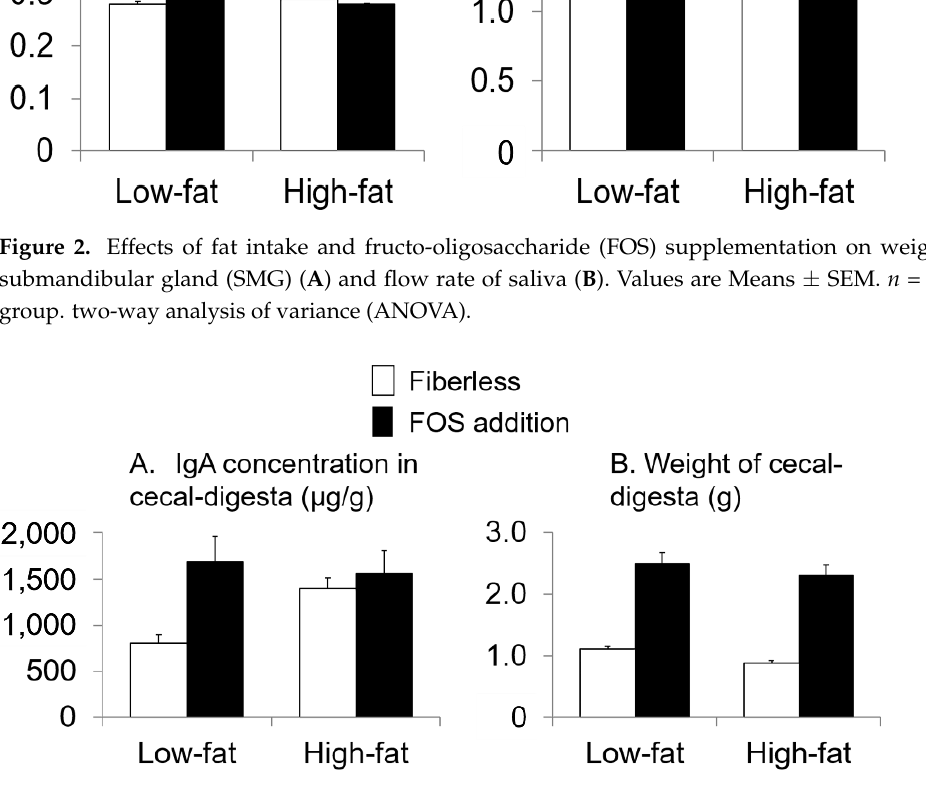
Figure 2. Effects of fat intake and fructo-oligosaccharide (FOS) supplementation on weight of sub- mandibular gland (SMG) ( A ) and flow rate of saliva ( B ). Values are Means ± SEM. n = 8 per group. two-way analysis of variance (ANOVA).